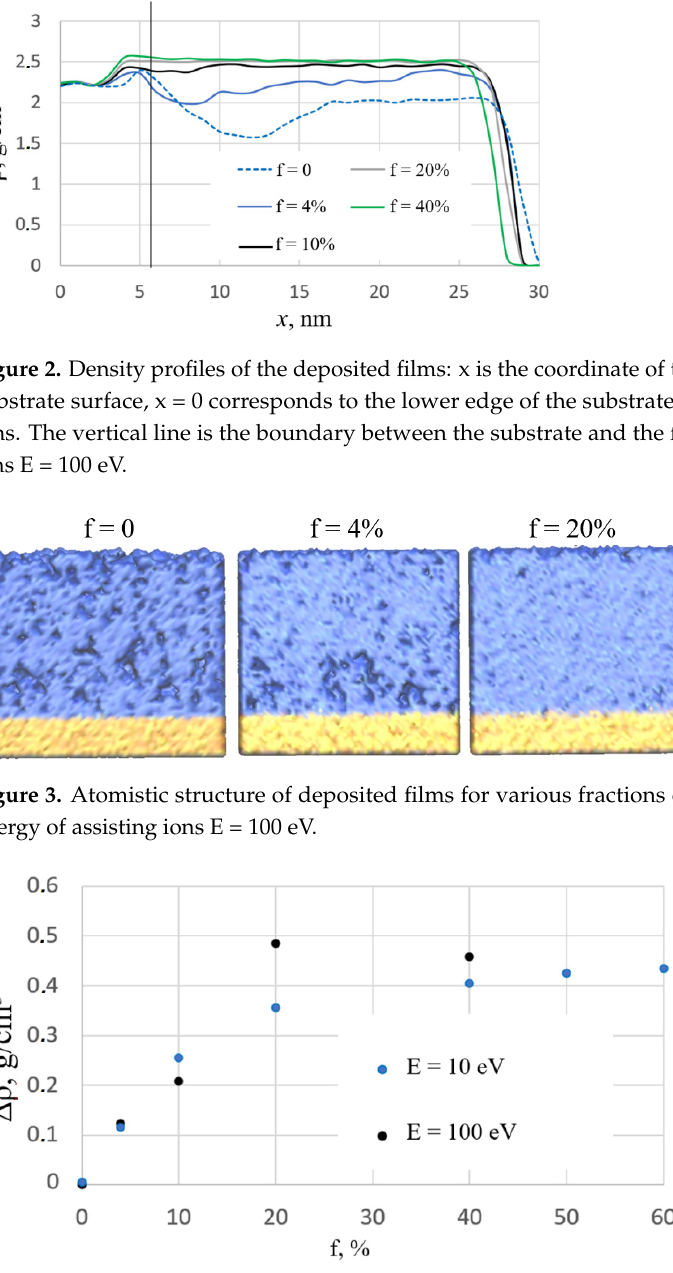
Figure 4. Dependencies of change in the film density ∆ ρ on the fraction of assisting ions, f; E is the energy of assisting ions.